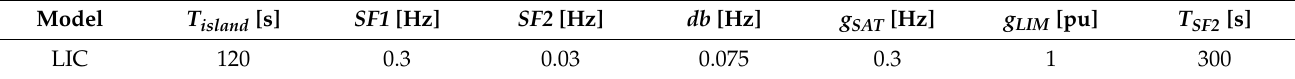
Table 3. Parameters of the LIC model.